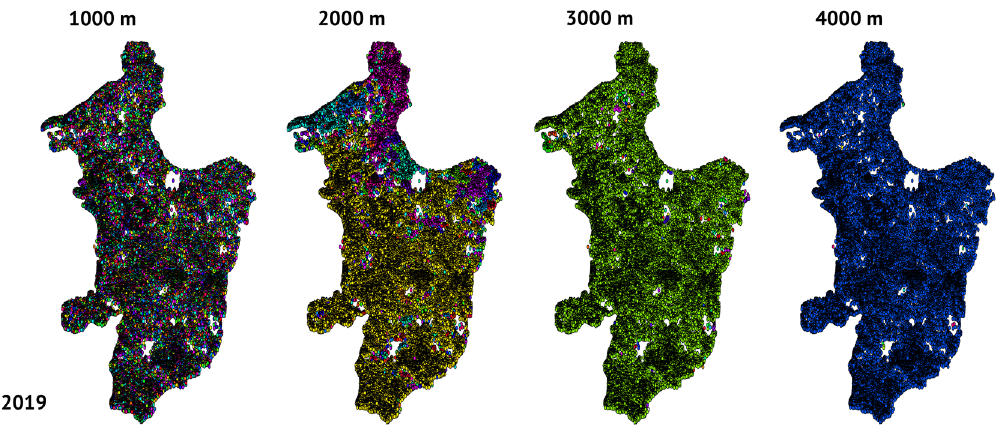
Figure 5. Comparison of global coalescence based on different dispersal distances (1000 m, 2000 m, 3000 m, 4000 m, 5000 m) comparing the patterns of clusters for 2019. Remnant centroids are shown as colored points. If two or more remnants are within the indicated dispersal distance from each other, they are denoted with the same randomly chosen color to indicate that they are part of the same cluster. Networks built with dispersal distances < 1000 m had too many isolated nodes that were too far apart to form clusters to discern any patterns. Figures were generated using